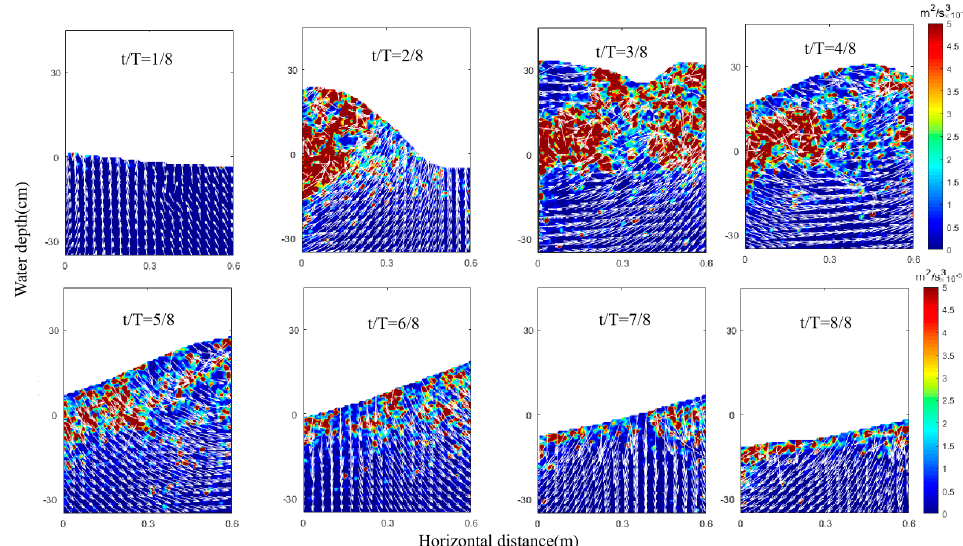
Figure 18. Spatial distribution of turbulent dissipation rate for 35 cm breaking wave. The vertical depth data of oil is dimensionless, where Z is the actual position height, then Z min and Z max are the height above horizontal and the deepest sinking depth of oil respectively. Dimensionless parameter α = ( Z − Z min )/( Z max − Z min ) is the normalized vertical height. Then, the reference Froude number is used to calculate the dimensionless numbers of significant wave height and turbulent energy dissipation rate ε , namely: ε H/(gH) 3/2 , where H is the water depth and g is the gravitational acceleration. The vertical distribution of turbulent energy dissipation rate (Figure 19) shows that the dimensionless spatial distribution of turbulence is mainly divided into three parts. When T/4 < t < T/2, turbulence will generate and maintain stability in this region, which is called “turbulence saturation region”, and its influencing factors are mainly related to the breaking scale of incoming bubbles during wave breaking. In a certain area, after the turbulence is saturated, the energy loss increases during wave breaking, and the dissipation effect of turbulence will not increase. Its energy is mainly transmitted to the plume generated by the bubble entering the water. When t > T/2, the turbulence intensity decreases linearly, which is mainly due to the weakening of turbulence generation and diffusion. When t > T, the flow field. The reason can be simply summarized as the promoting effect of bubbles on the formation of turbulence. The energy carried by the bubble into the water is converted into potential energy. After the bubble enters the water, there are a large number of vortices and small-scale turbulence in the wake. Because the velocity of the bubble at the maximum water entry depth is zero, the turbulent energy dissipation rate at the maximum water entry depth in the image remains at a small level. At the same time, it can be observed